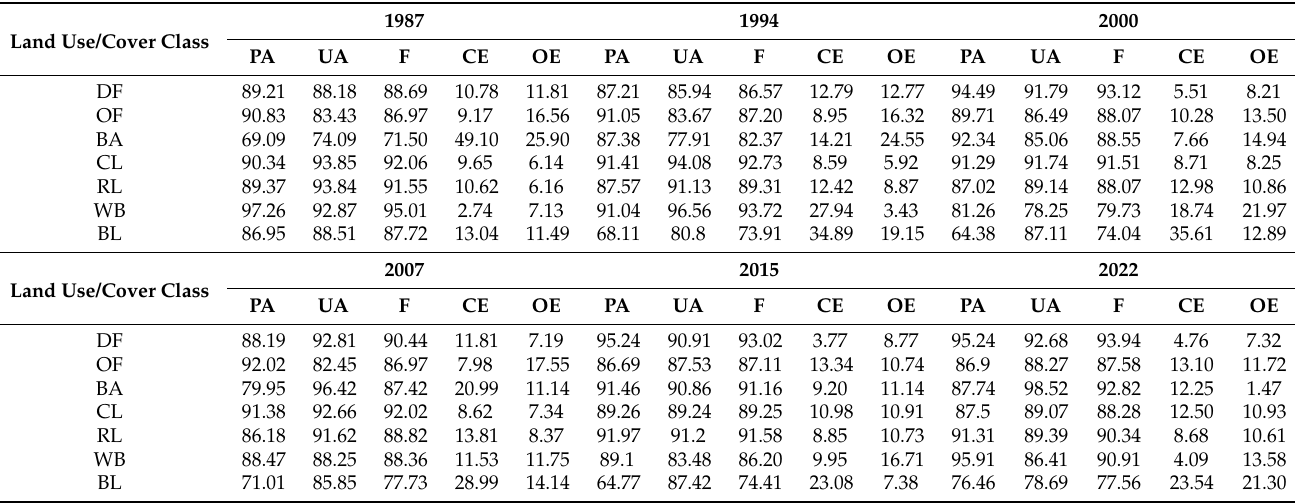
Table 3. Image classification accuracy evaluation for the studied years.